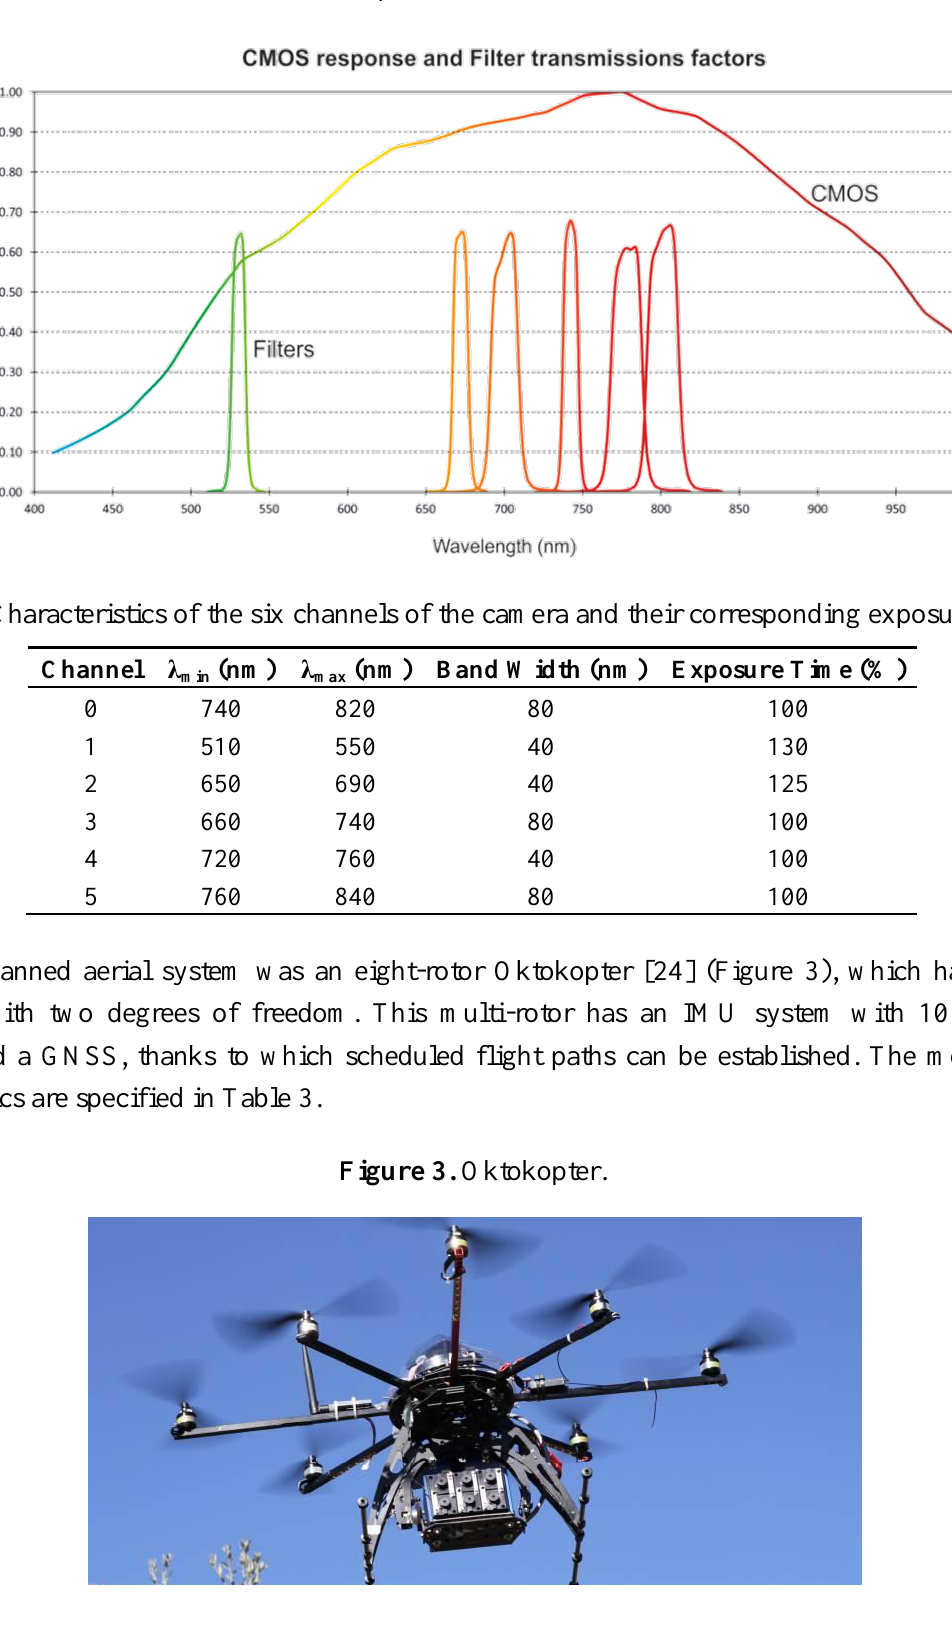
Figure 2. Complementary metal-oxide-semiconductor (CMOS) and filter spectral performance of the Mini-MCA multispectral camera.